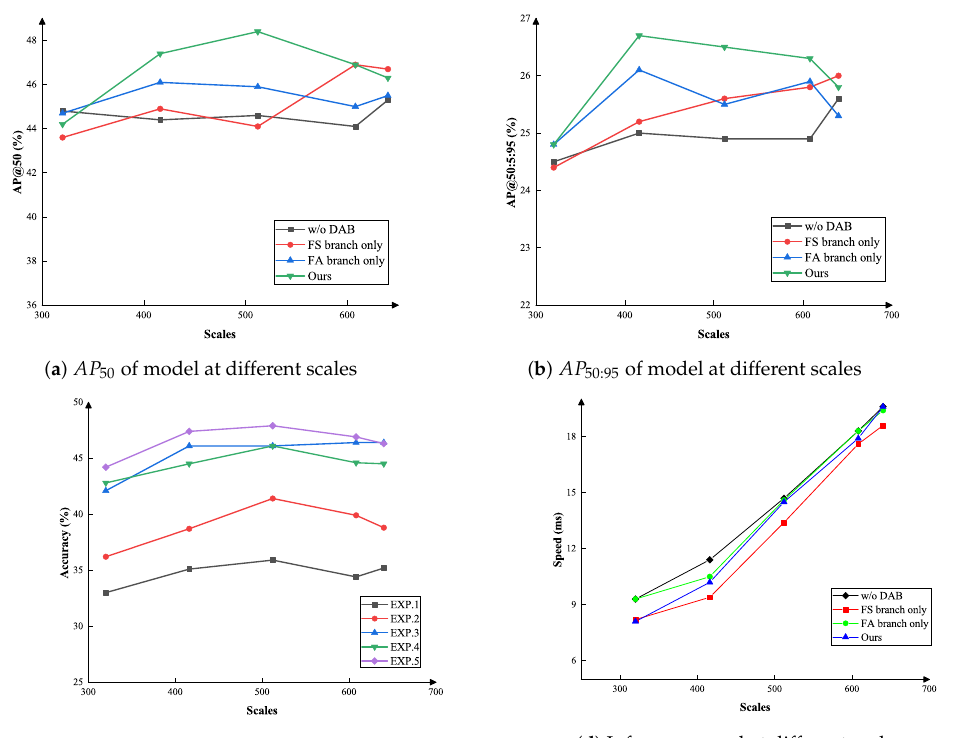
Figure 9. The ablation study for the scales of different target domain inputs. The results are from Pascal VOC → Clipart. The scale of image is fixed to be 640 pixels in the source domain, and we resize the different scales of image in the target domain, as shown in the X-axis.